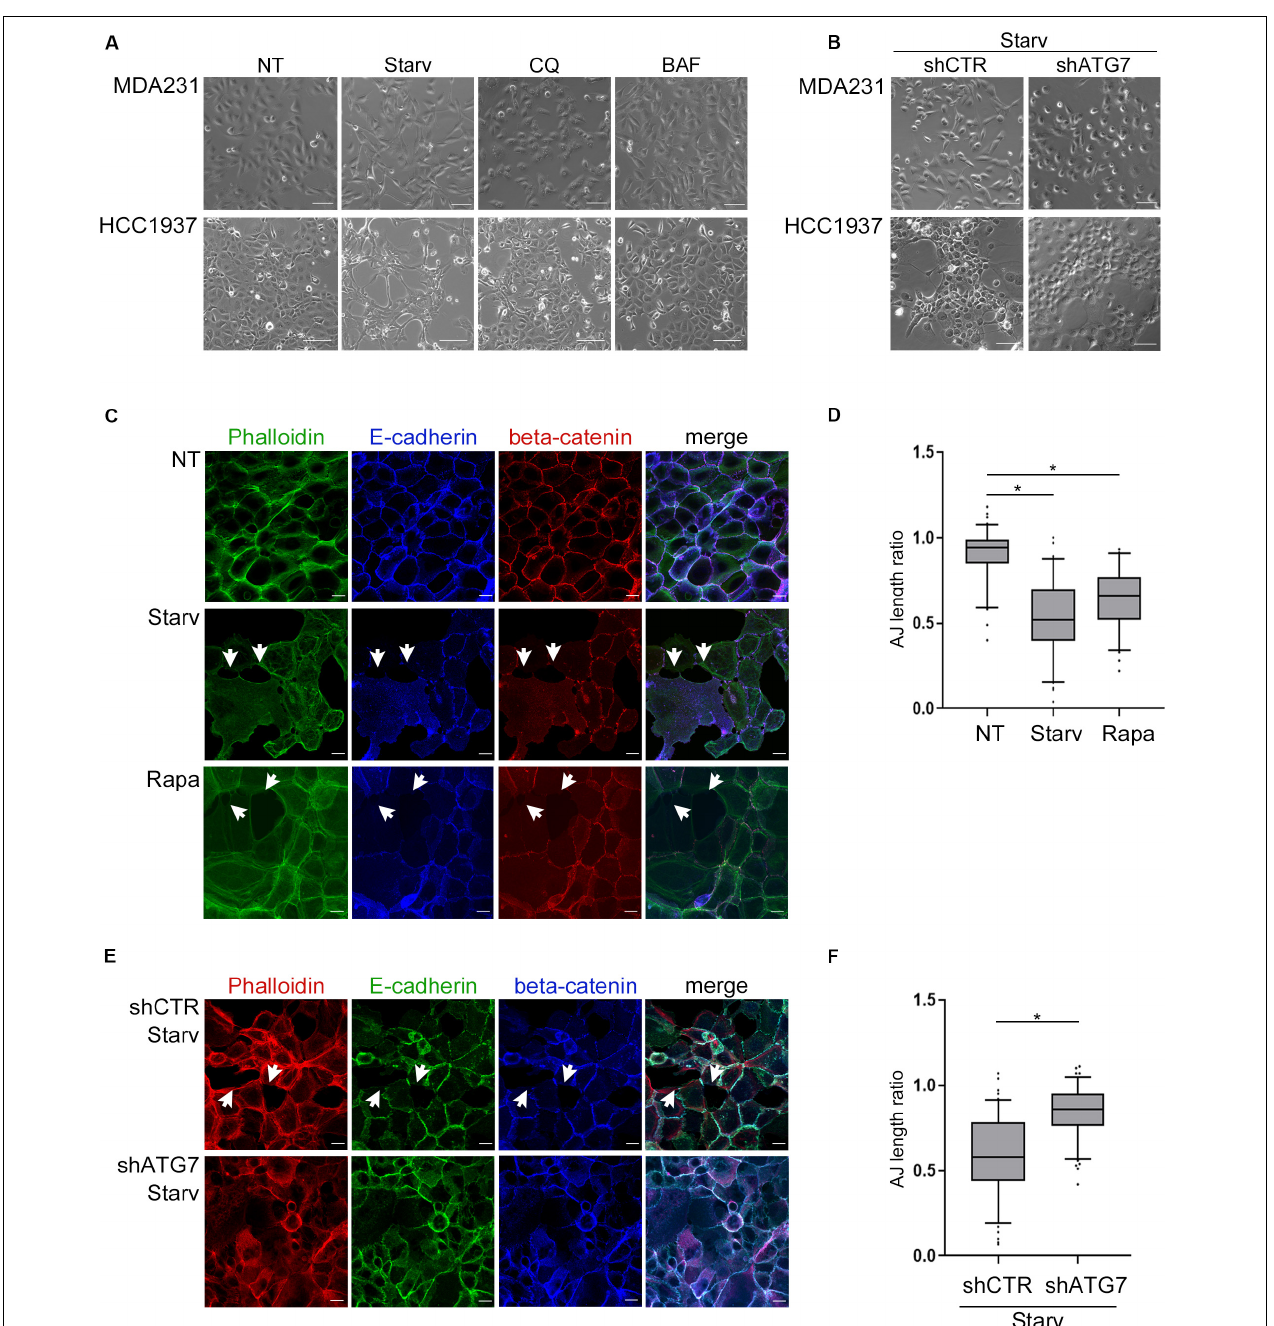
FIGURE 2 | Autophagy induction impinges upon cell morphology and cell-cell adhesion. (A) Depicting images (bright field) of MDA231 and HCC1937 untreated (NT), starved (Starv; 8 h) or treated with either CQ or BAF (8 h). Scale bar, 50 µ m. (B) Representative images of MDA231 and HCC1937 cell models silenced for ATG7 (shATG7) and the respective controls (shCTR). Cells were starved for 8 h. Scale bar, 50 µ m. (C) Confocal fluorescence images of HCC1937 untreated (NT), starved (Starv) or treated with 5 µ M Rapamycin (Rapa) for 24 h and immunostained with Alexa Fluor 488 Phaolloidin, E-cadherin/Alexa Fluor 633 (E-cad) and beta-catenin/Alexa Fluor 594. White arrowheads indicate representative loss of cell-to-cell cohesion. Scale bar, 20 µ m. (D) Quantification of adherens junctions (AJ length ratio; measured as described in section “Materials and Methods”) of the HCC1937 cells treated as described in (C) . (E) Confocal fluorescence images of HCC1937 cells silenced for ATG7 (shATG7) and the related control (shCTR) starved for 8 h. Cells were immunostained with E-cadherin/Alexa Fluor 488 (E-cad), beta-catenin/Alexa Fluor 633 and Alexa Fluor 594 Phaolloidin to probe F-actin. White arrowheads indicate representative lack of cell-to-cell cohesion regions. Scale bar, 20 µ m. (F) Quantification of AJ length ratio of the cells described in (E) . (D,F) At least 100 cells per sample were measured in three independent experiments. Lines within the boxes mark the median, boundaries represent the 25th and the 75th percentiles, whiskers below and above the boxes indicate the 5th and 95th percentiles, respectively, and dots the outliers. An unpaired t -test was used to assess statistical significance. * p < 0.001.